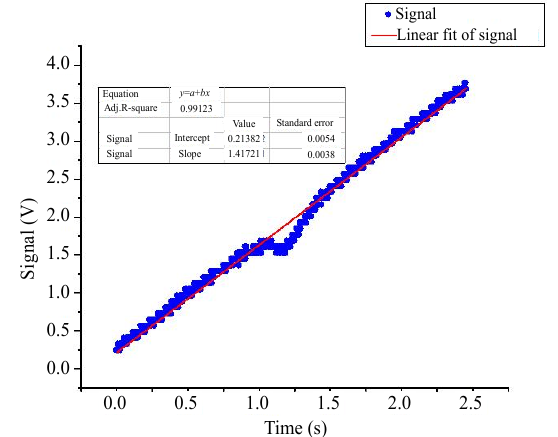
Fig. 7 Laser intensity through the reference gas cell.